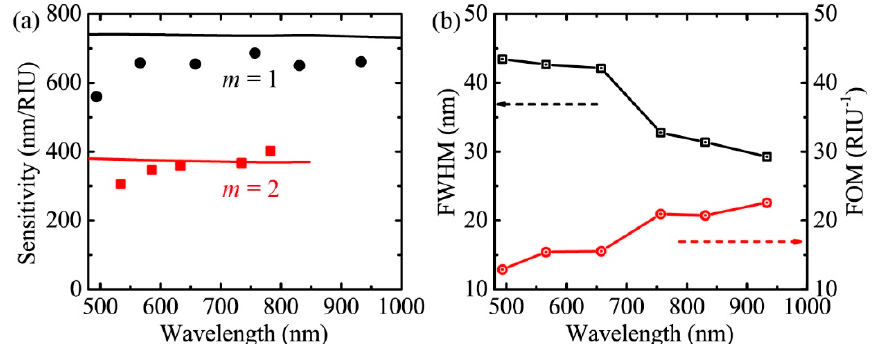
Figure 6. ( a ) Comparison of the experimental sensitivity and the theoretical sensitivity under the condition of P = 720 nm, n a = 1.3402. The black circles and red squares are experimental data. The black and red lines are theoretical data. ( b ) The FWHM and FOM as a function of the resonant wavelength.